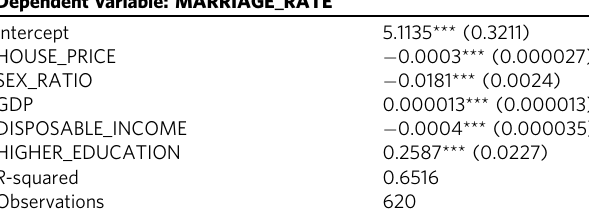
Table 3 Regression results for marriage rate.